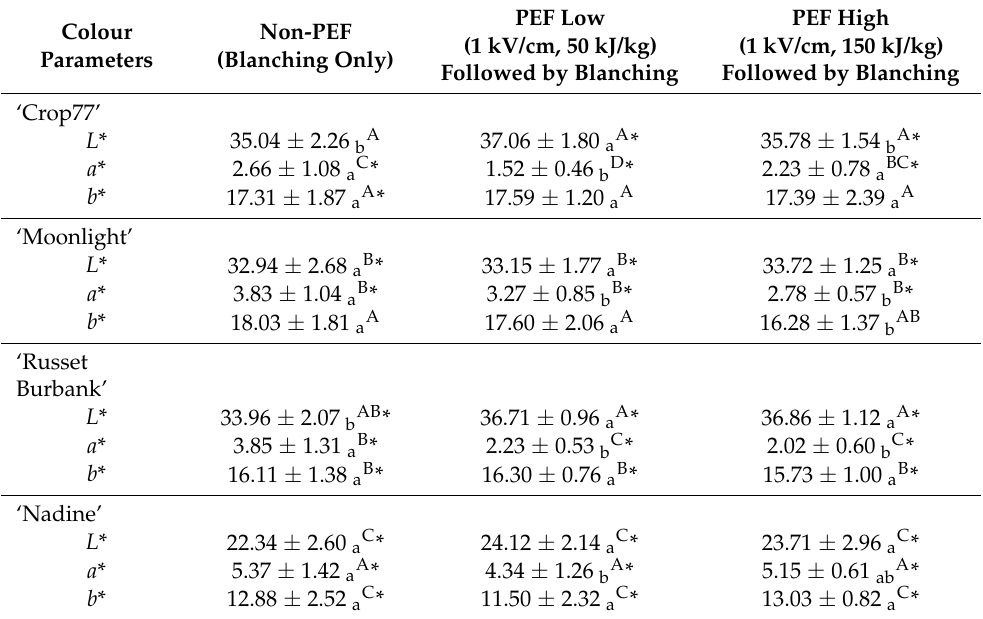
Table 3. The effect of sequential PEF and blanching pre-treatments on the L *, a * and b * values of fried potato slices (180 ◦ C for 3 min) from ‘Crop77’, ‘Moonlight’, ‘Nadine’, and ‘Russet Burbank’. Colour